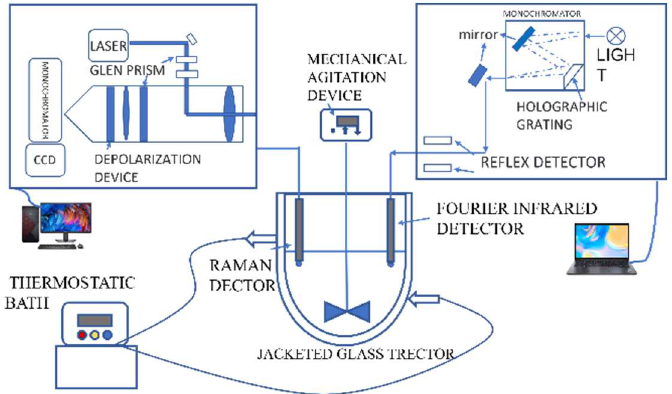
Figure 1. Experimental apparatus utilized in the experiments. Table 2. Compositions of the solution.